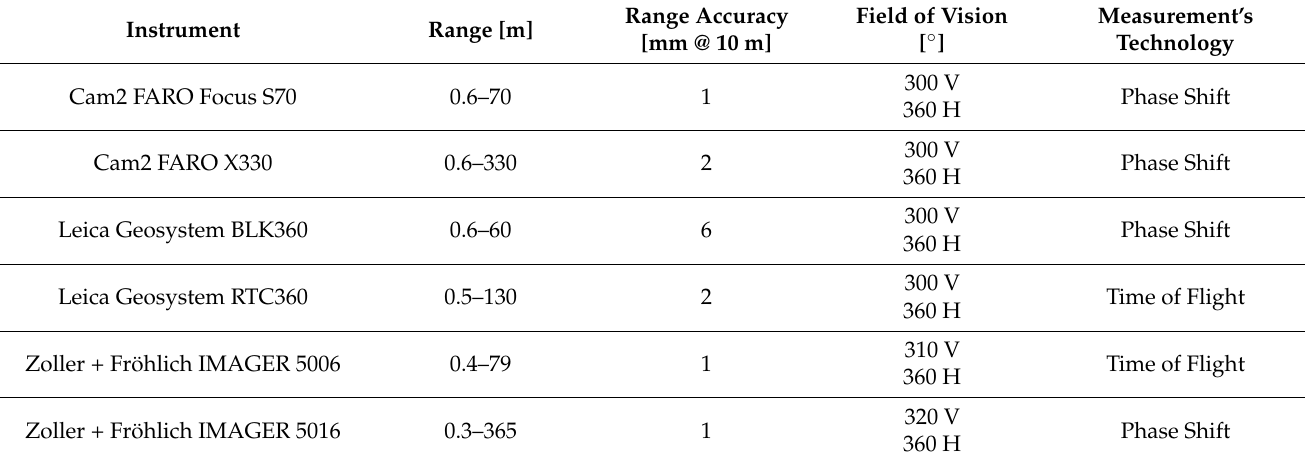
Table 1. Information of the instruments adopted during the geometrical survey.